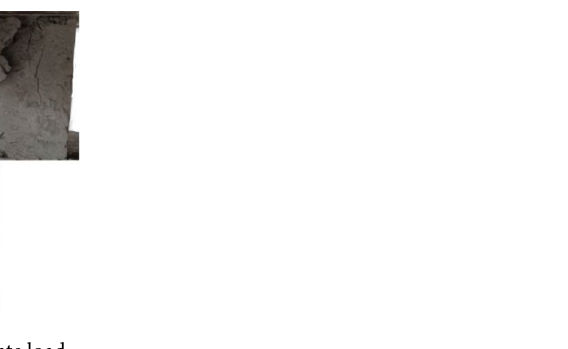
Figure 20. The sample failure forms at ultimate